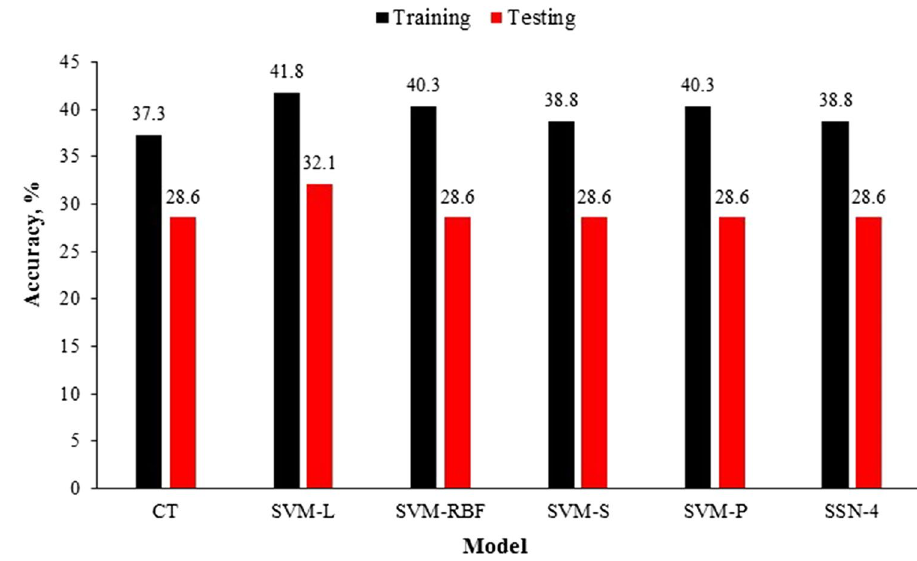
Fig. 1 Classification accuracy of sewers’ damages